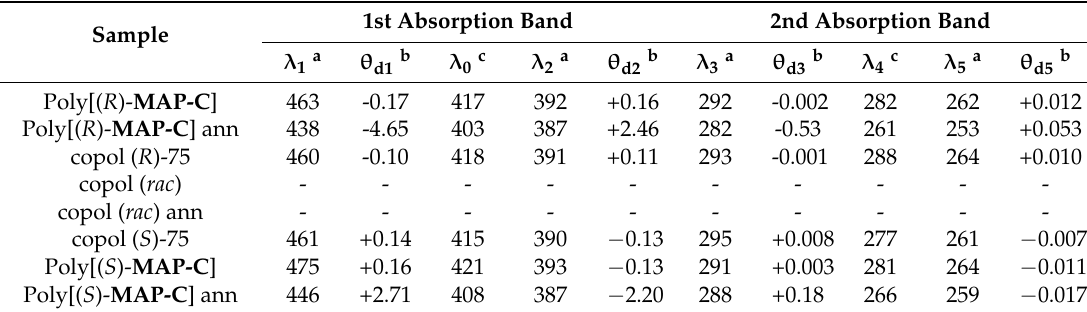
Table 2. CD spectra of thin films of the studied azobenzene derivatives before and after annealing at 200 ◦ C for 100